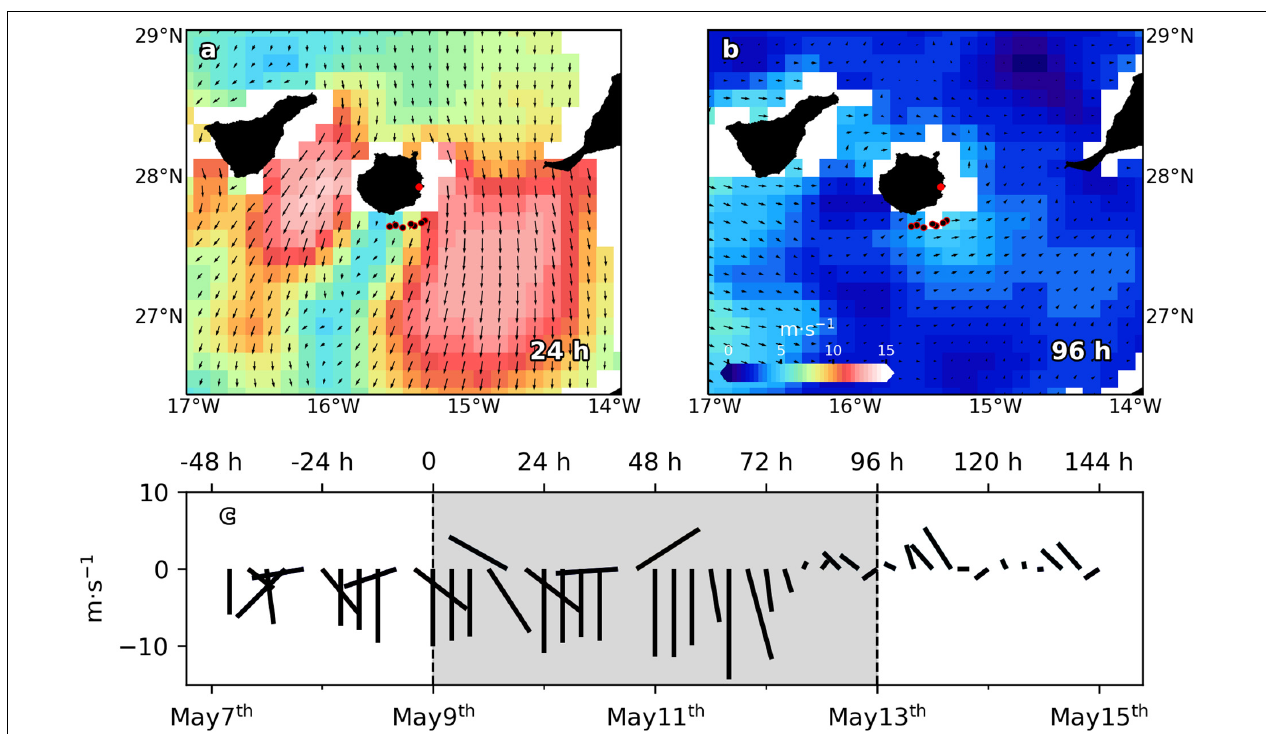
FIGURE 1 | Sea surface winds (m · s - 1 ) and direction (black arrows) from scatterometer on the Meteorological Operational satellite MetOp-A (European Space Agency, ESA), for (a) May 10th 2011 (24 h) and (b) May 13th 2011 (96 h). Black dots with red borders indicate stations positions. Red dot indicates Gando airport location. (c) Wind speed (m · s - 1 ) time series from May 7th to May 15th. Dashed vertical lines delimit sampling period. Negative (positive) values correspond with north (south) and east (west) wind